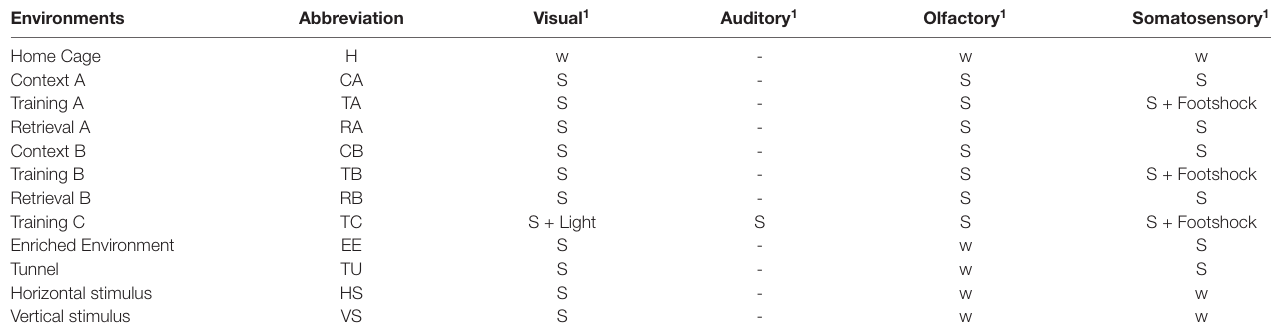
TABLE 1 | List of the used multimodal environments.